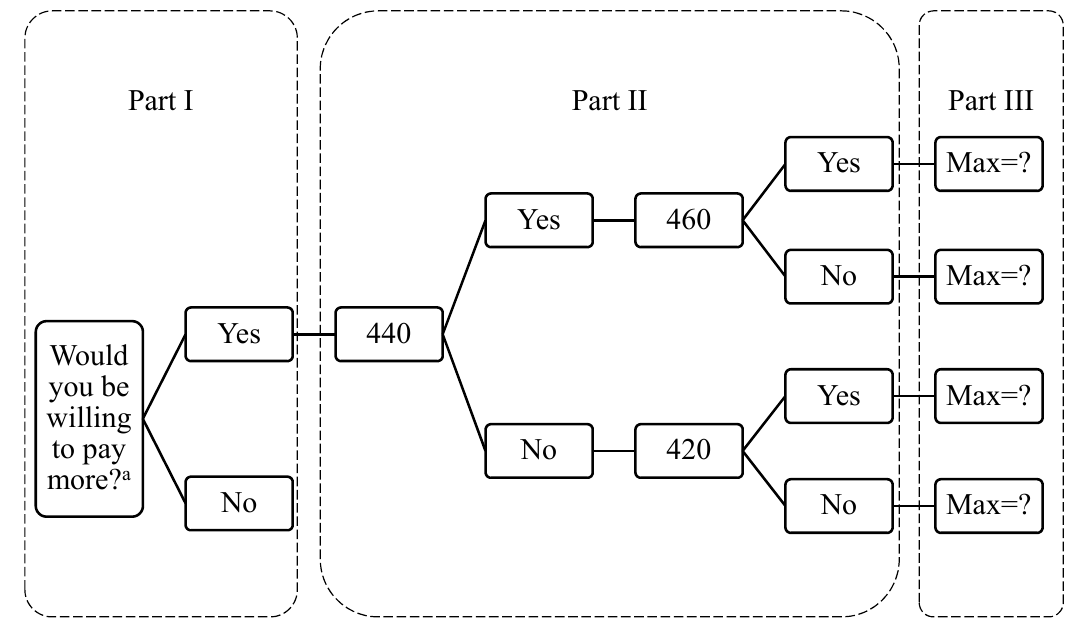
Figure 1. Quasi-bidding game of contingent valuation method. a There are two quasi-bidding games, “Would you willing to pay more than NT$360 of outpatient copayment to implement hierarchy of medical care?” and “Would you willing to pay more than NT$360 of outpatient copayment to have better medical service quality?”.